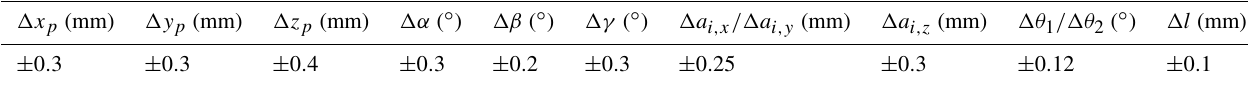
Table 2. Geometric errors of the L/R